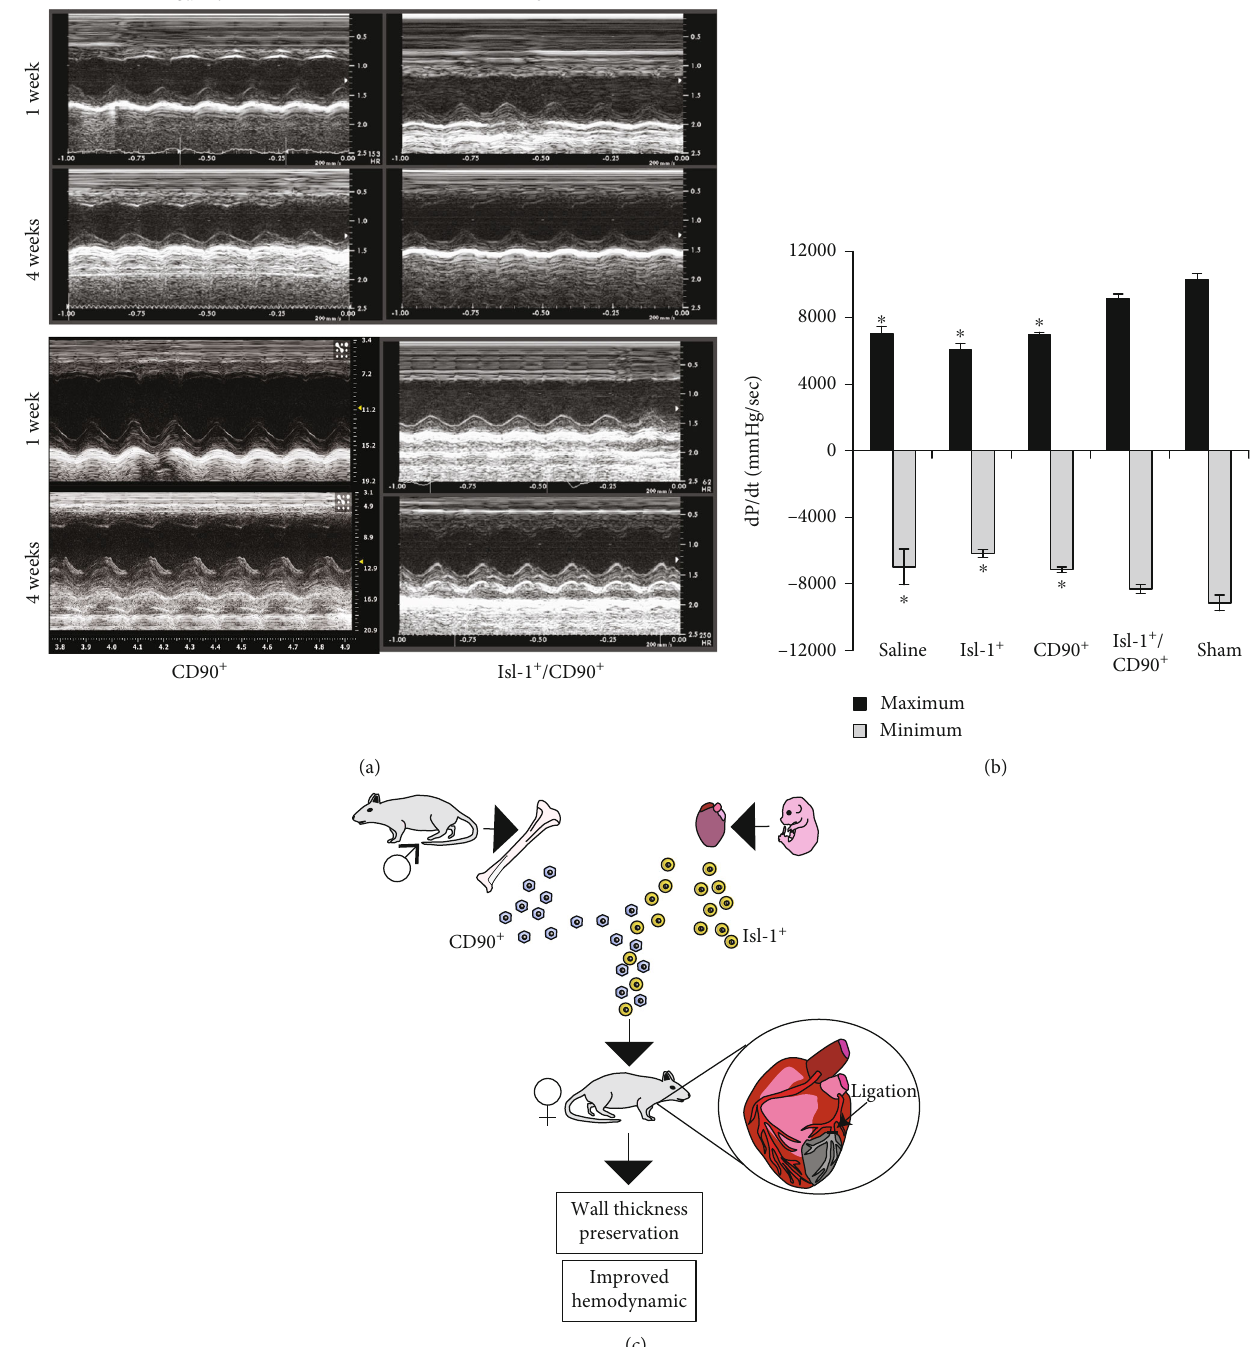
Figure 4: Combination of Isl-1 + cells and CD90 + cells leads to improved cardiac function, and schematic representation of combination stem cell administration on cardiac repair following LAD ligation induced MI. (a) Representative screenshots of echocardiograms at 1- and 4-week post-MI time points in all the four treatment groups (saline, Isl-1 + , CD90 + , and Isl-1 + /CD90 + ). (b) Hemodynamic parameter assessment by Millar catheterization revealed that the combination therapy group demonstrated a signi fi cant improvement of cardiac function compared to either monotherapy. There was no signi fi cant di ff erence between Isl-1 + /CD90 + and sham. (c) Isl-1 + cells derived from mouse embryos and adult bone marrow-derived CD-90 + cells work in combination to restore cardiac function and preserve wall thickness in the LAD ligation model of MI. In vivo cells work in synergy to carry out healing and the use of two cell types may serve to optimize outcomes both for the target tissue in need of repair and for facilitating donor cell